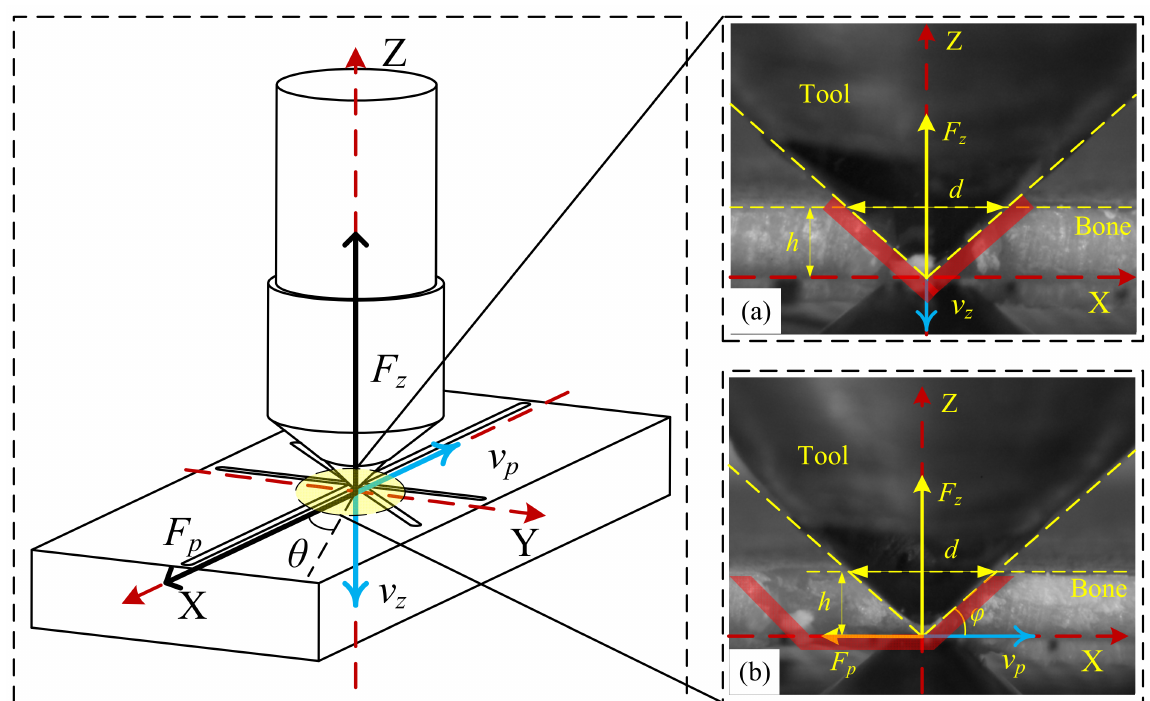
Figure 1. ( a , b ) Ploughing principle diagram.